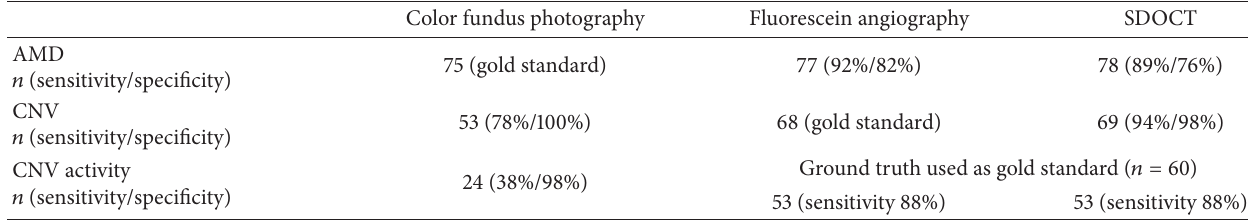
Table 2: Sensitivity and specificity in detecting AMD, CNV, and CNV